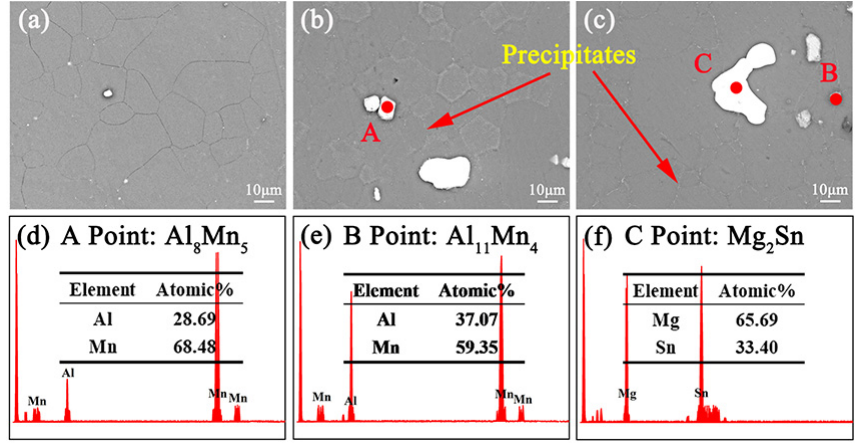
Figure 5. BSE-SEM micrographs of the single-aged ZTM641-xAl alloys, ( a ) x = 0, ( b ) x = 0.5, ( c ) x = 2, ( d – f ) corresponding EDS results of the points indicated in ( b , c